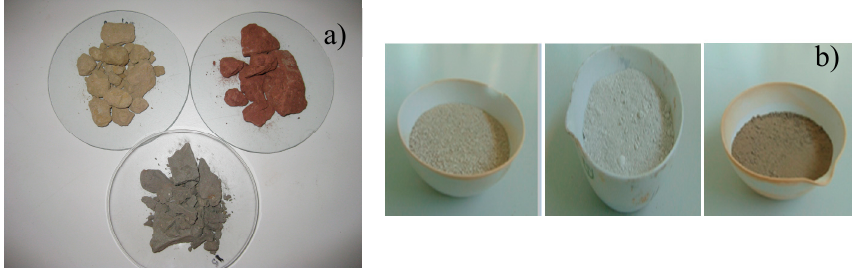
Figure 2. Raw materials: ( a ) Clay (Yellow, red and black); and ( b ) Wastes (Bagasse, diatomaceous and sludge).